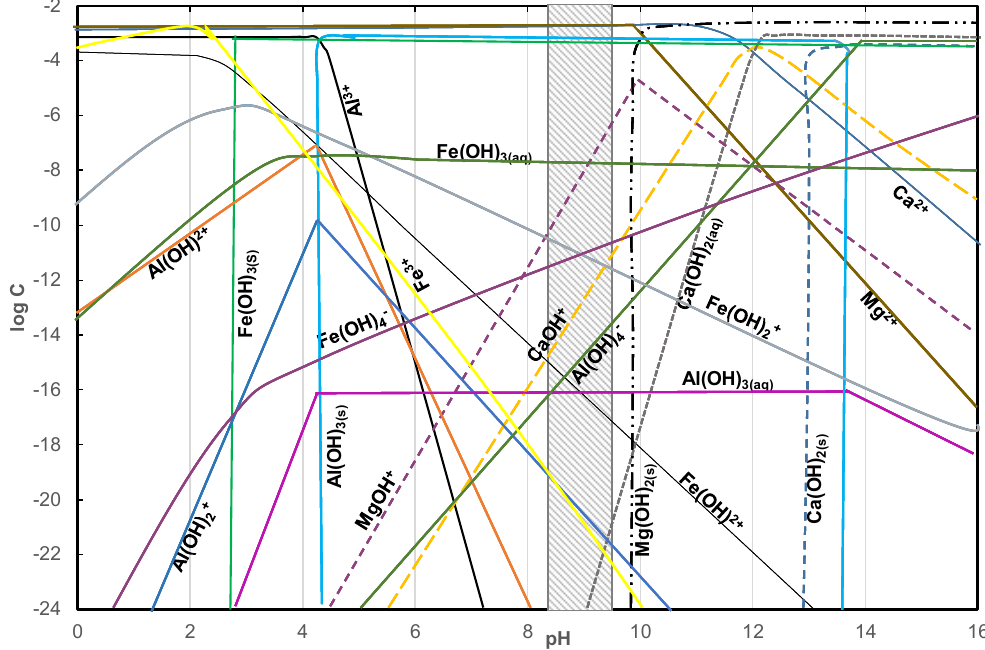
Figure 6. Log C-pH curve of Ca 2+ , Mg 2+ , Fe 3+ or Al 3+ at a concentration of 1.5 × 10 −3 mol/Lin the distilled water (Modified from Ruan et al., 2008; Ren et al. 2018) [4,26].